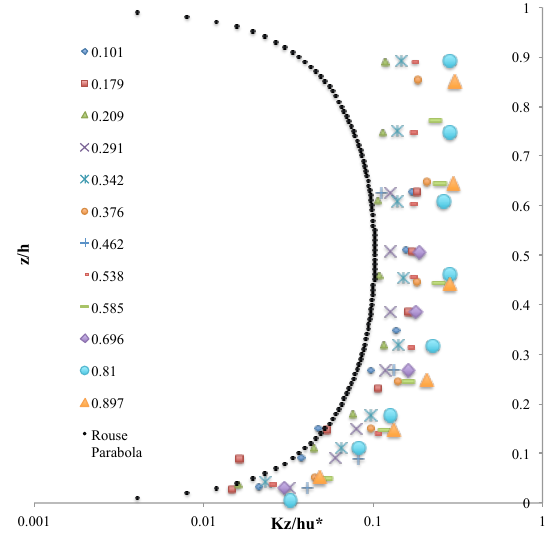
Figure 1. Vertical sediment diffusivity K z /Hu ∗ profiles for sed- iments with different ˜ V = V/u ∗ . The data has been reproduced from calculations done by Coleman (1970) on field data of Ander- son (1942). The generic Rousian profile of kinematic eddy viscosity has also been plotted. For most cases the Rousian profile underes- timates sediment diffusivity. There is a trend that vertical sediment diffusivity increases with increase in ˜ V ; but the trend is not obvious for some of the cases plotted above (e.g. between 0.585 and 0.696).